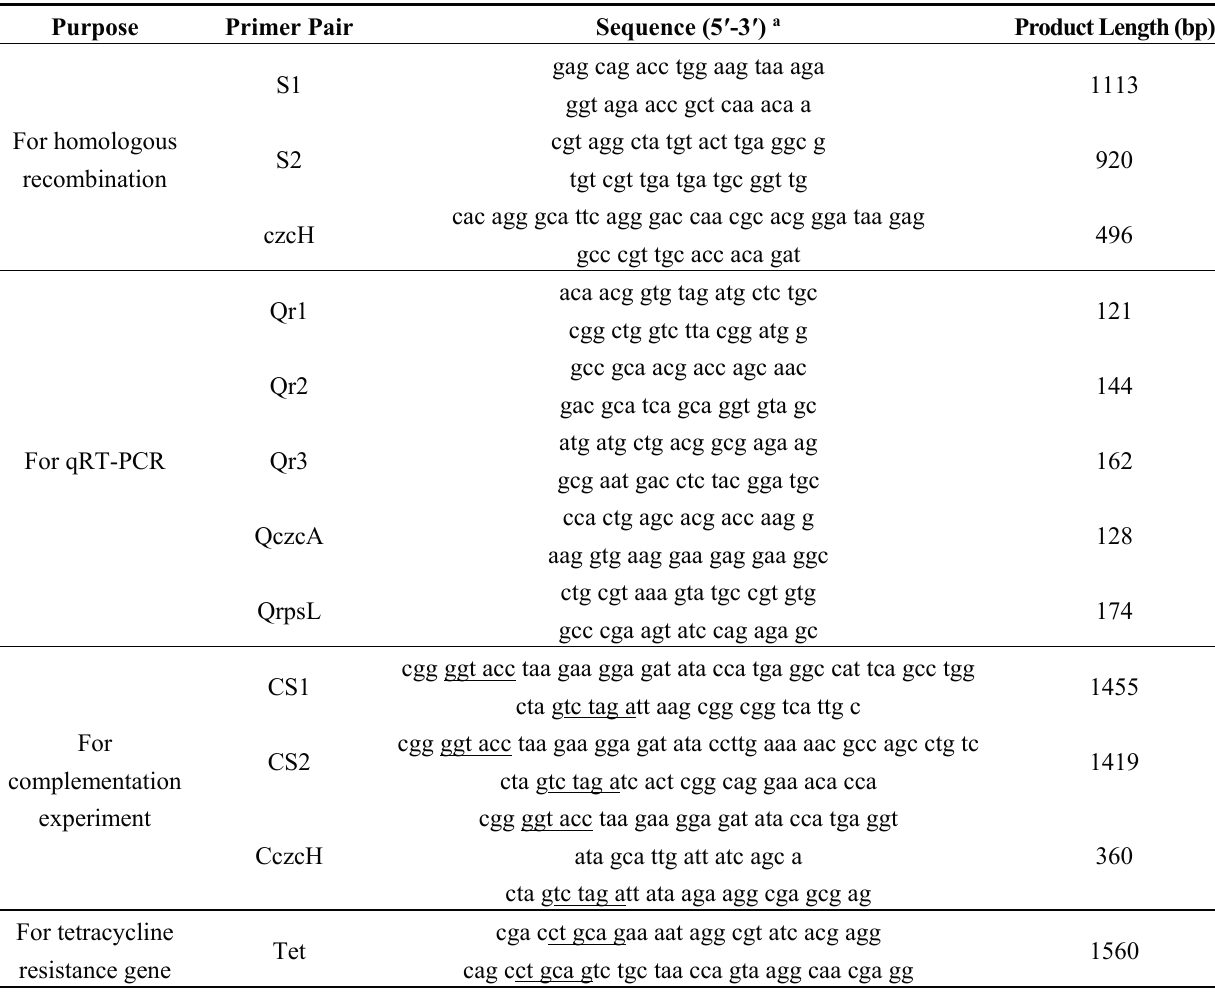
Table 3. Primers used in this